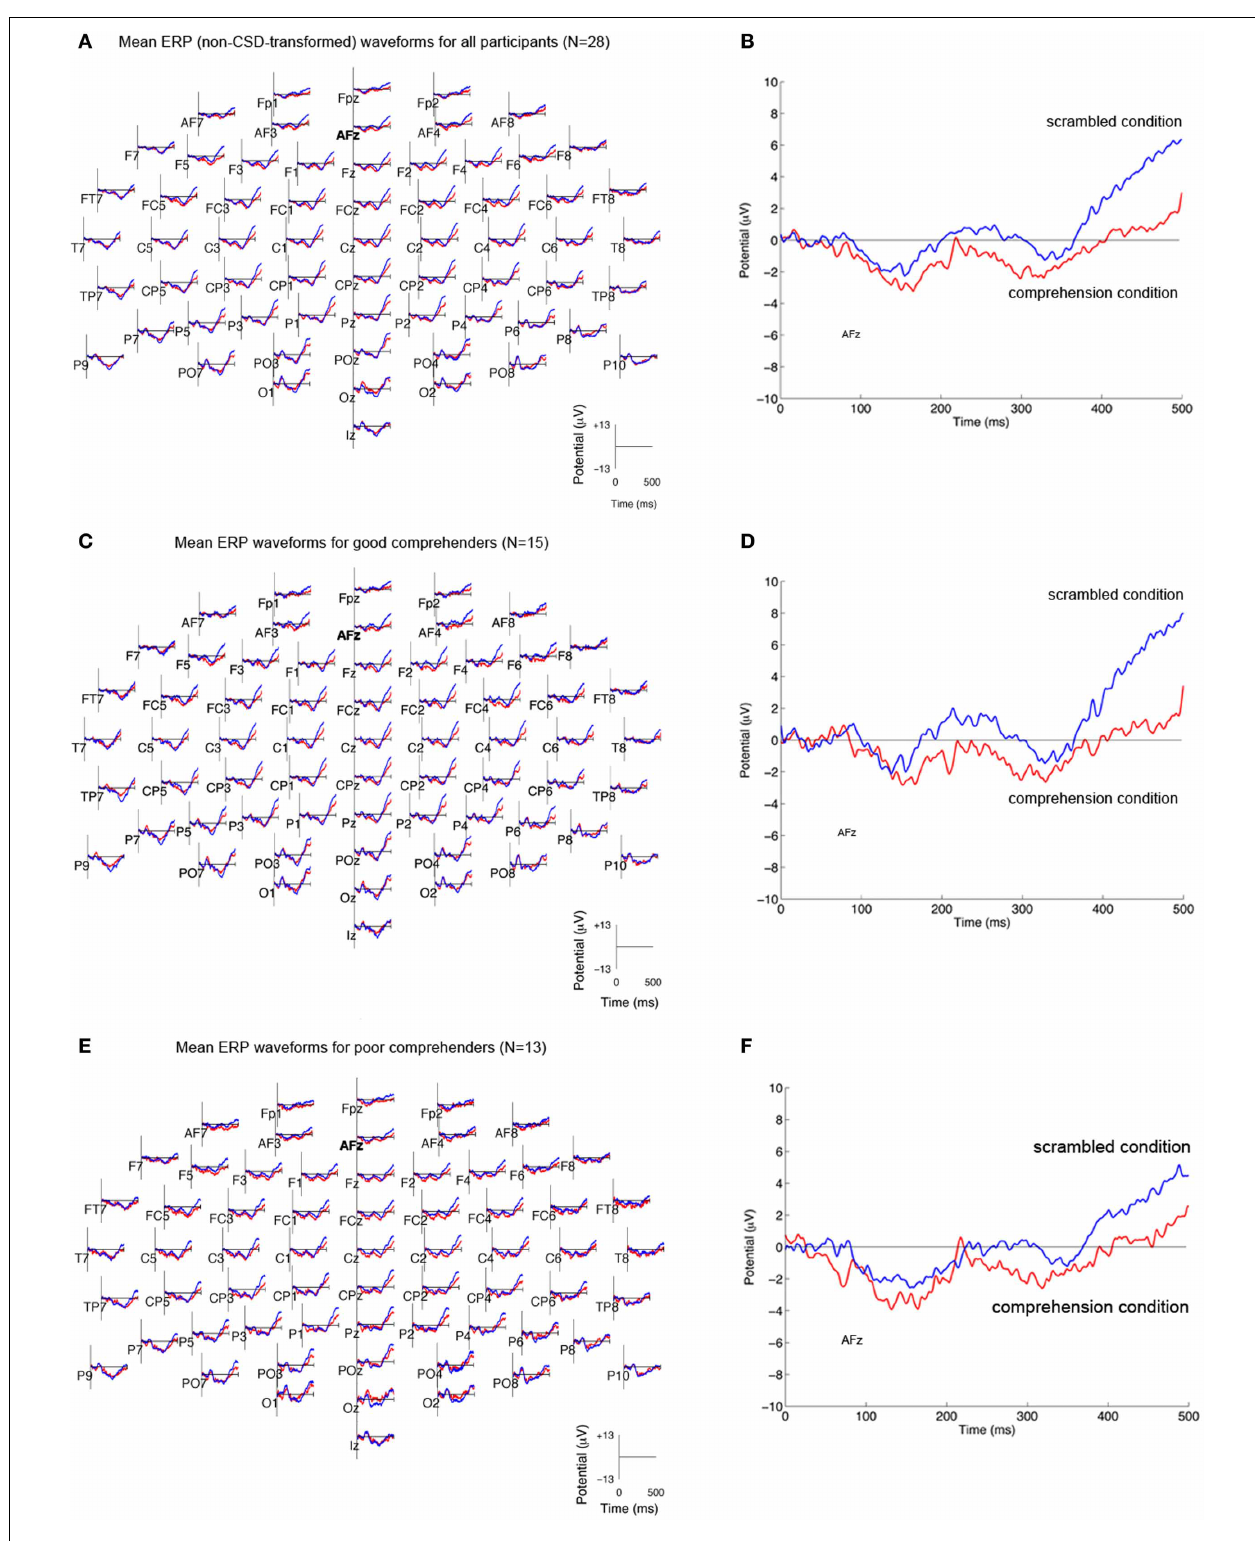
FIGURE A1 | Mean ERP (non-CSD-transformed) waveforms in the scrambled and comprehension conditions. (A) ERP waveforms (nose referenced) at each of 64 scalp sites time-locked to the onset of the target word (“and”) in the scrambled condition (blue) and the comprehension condition (red) for all participants ( N = 28). On the Y-axis, the voltages (in µ V)